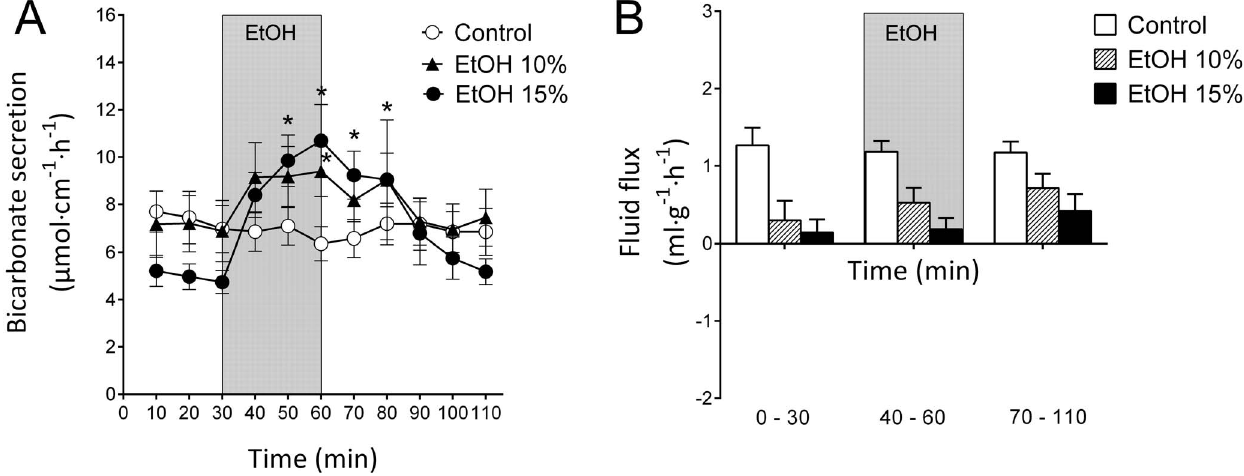
Figure 1. Effects of ethanol on duodenal mucosal bicarbonate secretion and duodenal fluid flux. A). The effects of luminal perfusion of the duodenum with 10% (n=6) and 15% (n=11) ethanol on duodenal bicarbonate secretion. Ethanol caused a concentration-dependent increase in duodenal bicarbonate secretion. In the control animals (n=8, perfusion with isotonic saline only), the bicarbonate secretion was stable during the experiment. B). The luminal perfusion of the duodenum with 10% and 15% ethanol did not have any effects on the duodenal net fluid flux. Similarly, isotonic saline did not influence the net fluid flux in the control animals. However, the basal net fluid flux was significantly (p , 0.05) higher in controls compared with that for both ethanol 10% and 15%. The values are the mean 6 SEM. *indicates a significant (p , 0.05) increase compared with baseline in the same group.